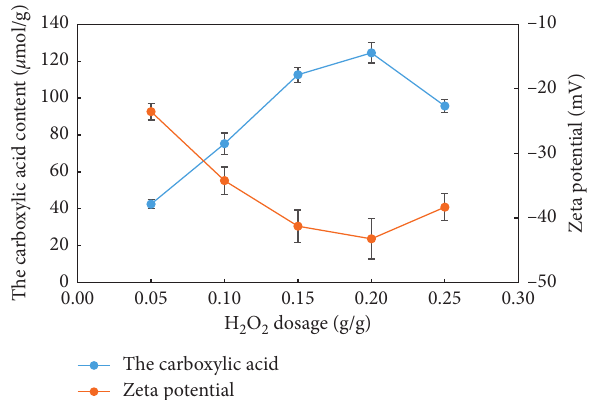
Figure 2: The effect of H 2 O 2 dosage on Fenton oxidation efficiency.